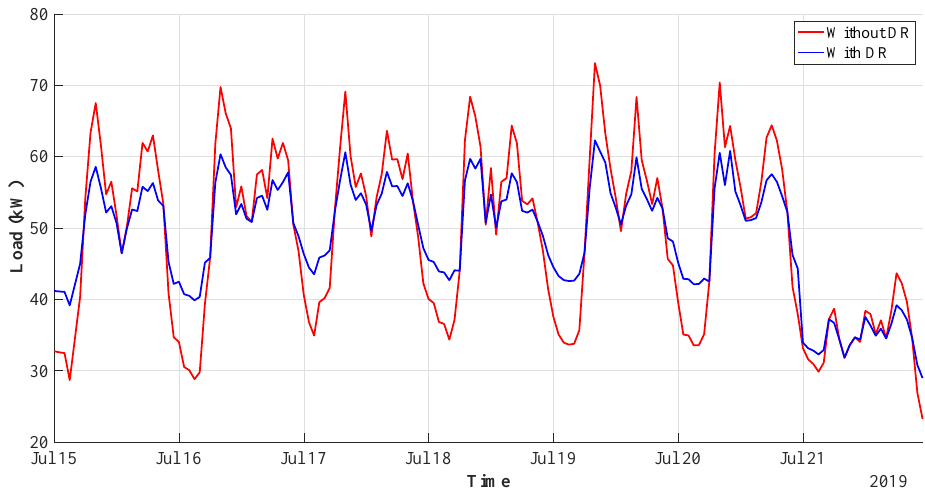
Figure 7. DR for all boats participating. The visual inspection of the plot indicates that the load factor has improved. Fur- thermore, the demand was properly shifted from peak to off-peak hours, leaving the total weekly demand unchanged. For the sake of clarity, the load shifting action is graphically presented in Figure 8.